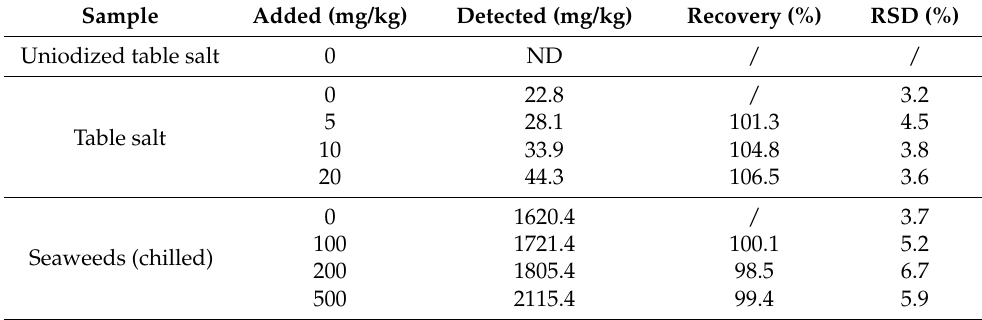
Table 2. Detection of iodide content in table salts and seaweeds ( n = 3).